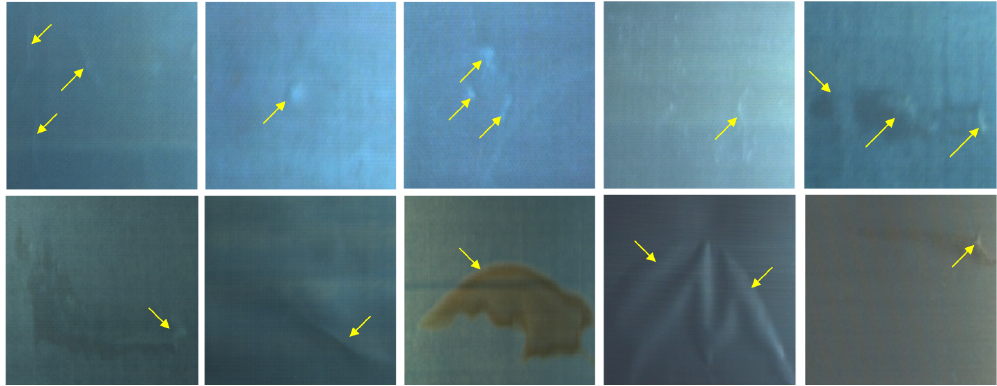
Figure 2. Blister defect samples of PLB